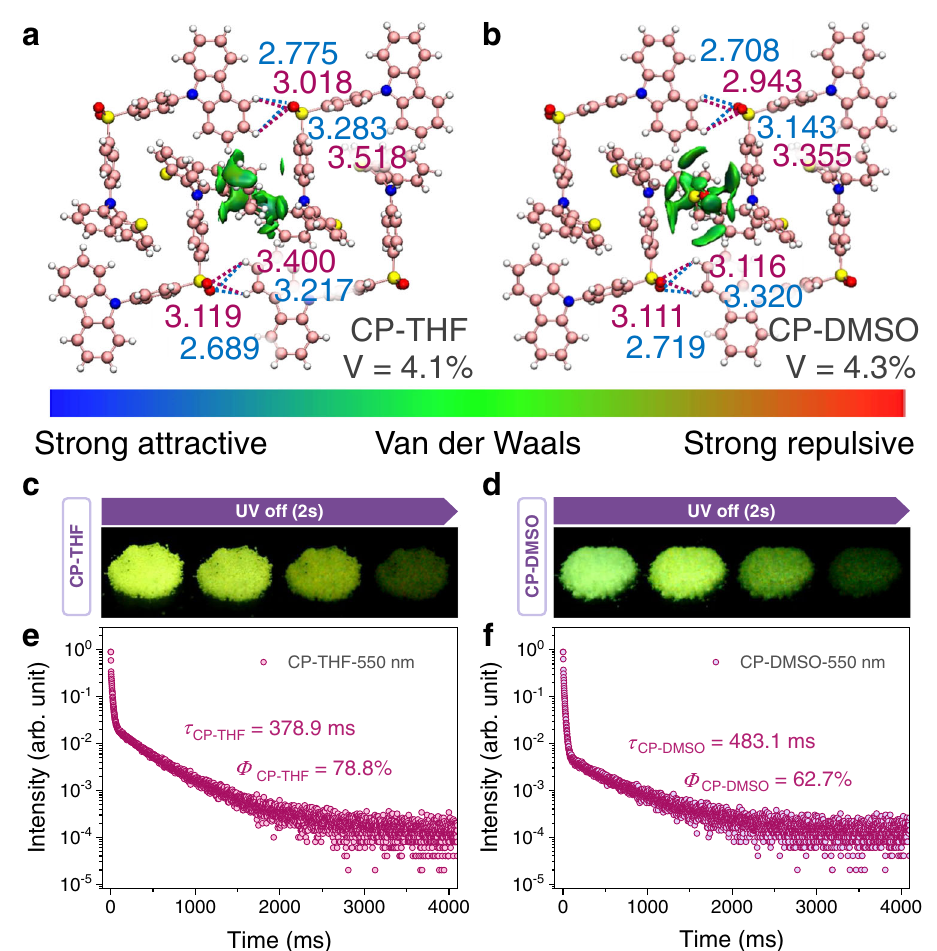
Fig.6|UniversalityofdynamicURTPfeatureinresponsetovariousguests. The distribution of intermolecular NCI regions at guest locations and intermolecular C – H ‧‧‧ O=S interactions of single-crystal structures of a CP-THF and b CP-DMSO. Colorcode:pink,C;red,O;blue,N;yellow,S;white,H.Freevolumesaregenerated